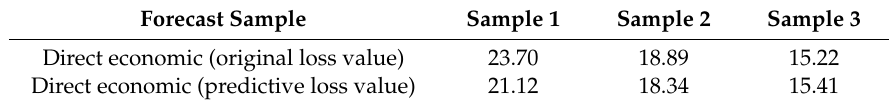
Table 15. Prediction of storm surge disasters based on support vector machines (unit: $100